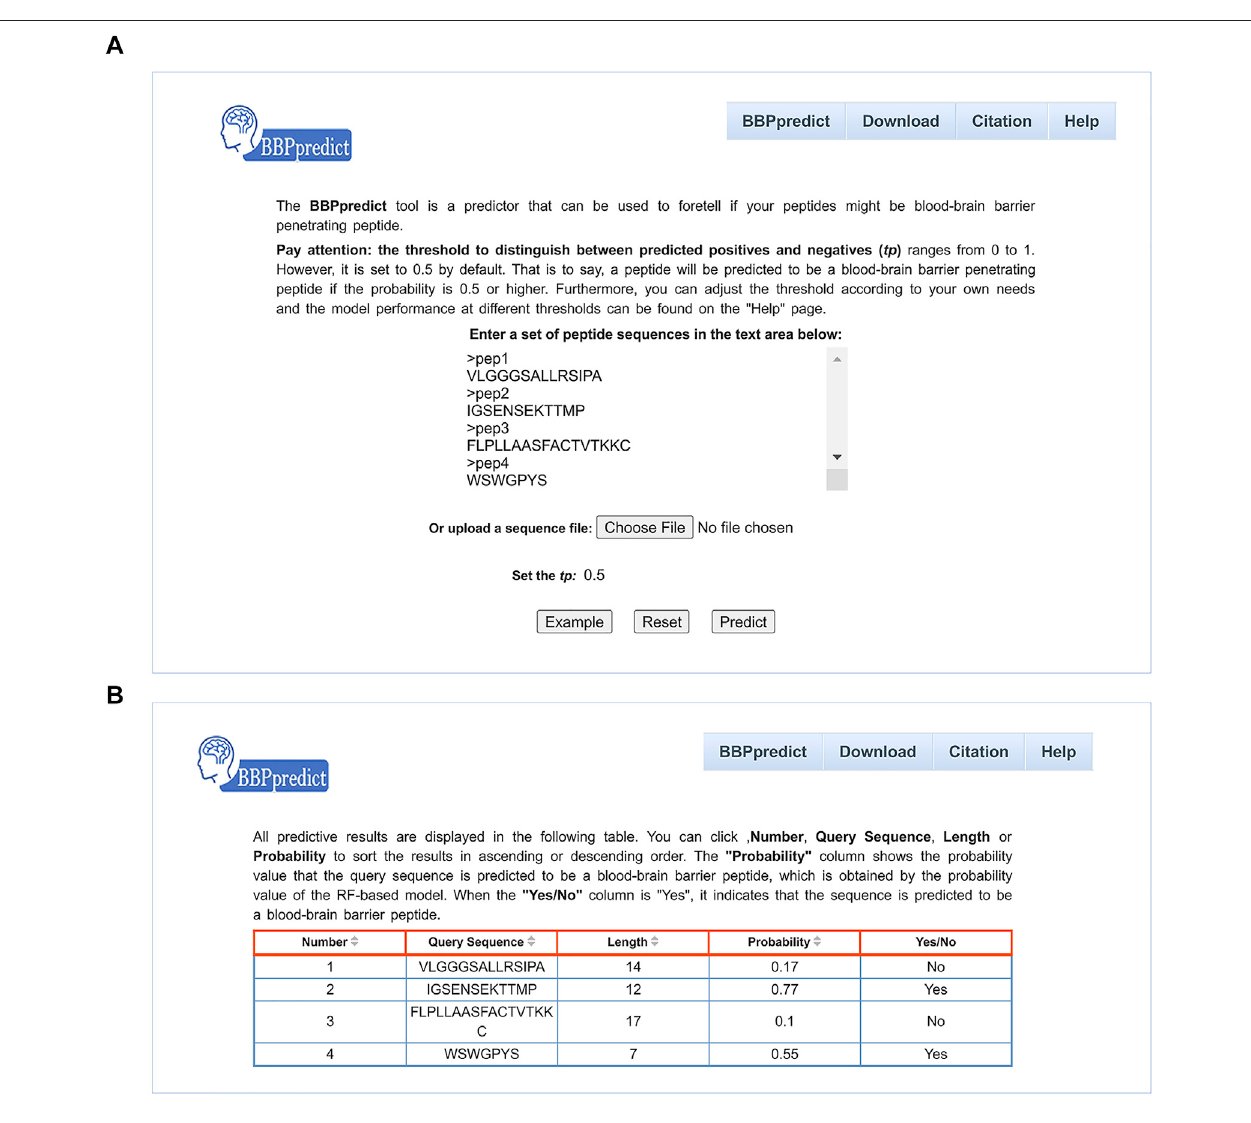
FIGURE3| WebinterfaceofBBPpredict. (A) Thequerysequencesandthreshold oftheprobabilityvalue(tp)arerequiredtobesubmittedintheinputinterface. (B) The result page returned from BBPpredict.